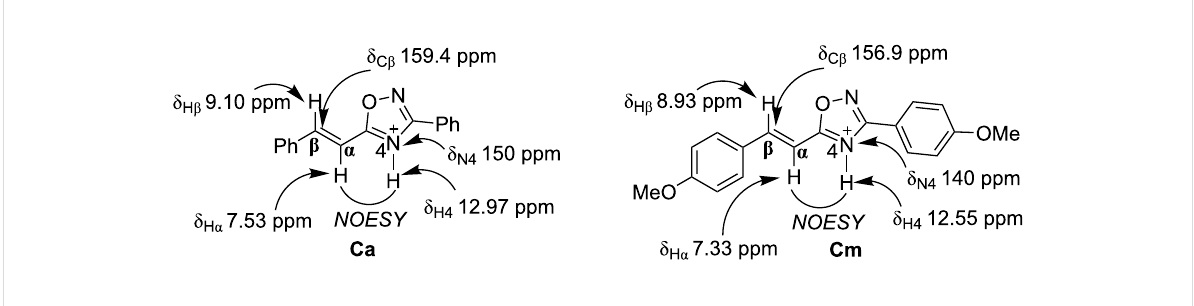
Figure 3: Selected 1 H, 13 C, 15 N NMR data for cations Ca and Cm generated by protonation of oxadiazoles 1a and 1m at the N 4 nitrogen (FSO 3 H, − 80 °C for Ca , and − 60 °C for Cm , with CH 2 Cl 2 as internal